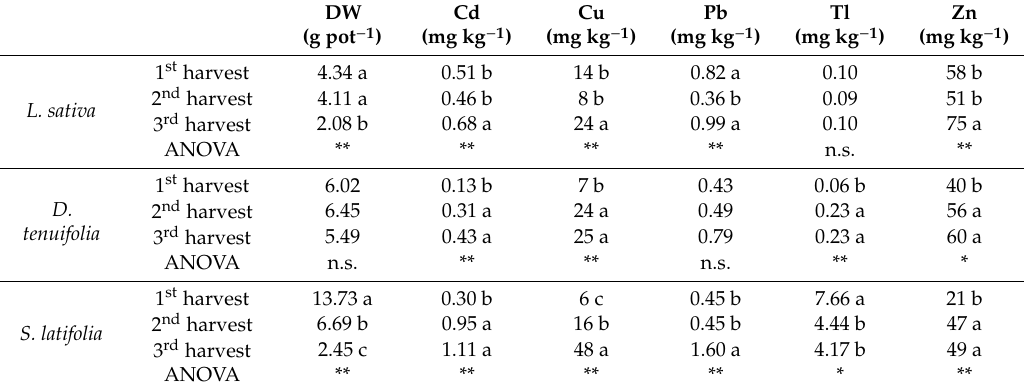
Table 3. Plant biomass (g d.w.) and concentration of PTEs (mg kg − 1 d.w.) in shoots of L. sativa , D. tenuifolia and S. latifolia at the first, second and third harvests.